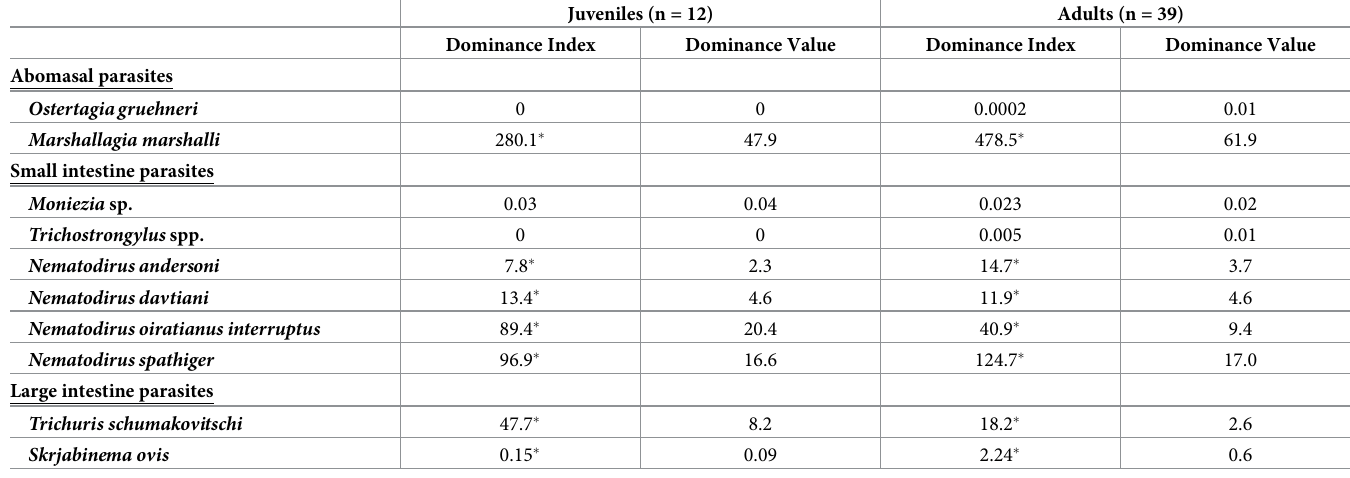
highest dominance index and dominance value, followed in both cases, by N . spathiger and N . oiratianus interruptus . These dominance indicators were several times higher in M . mar- shalli compared to any other species in both juvenile and adult sheep (Table 2). Table 2. Species dominance of gastrointestinal helminths in Dall´s sheep categorized as Juveniles (sheep younger than 24 months, including two lambs younger than 12 months) and adults (24 months and